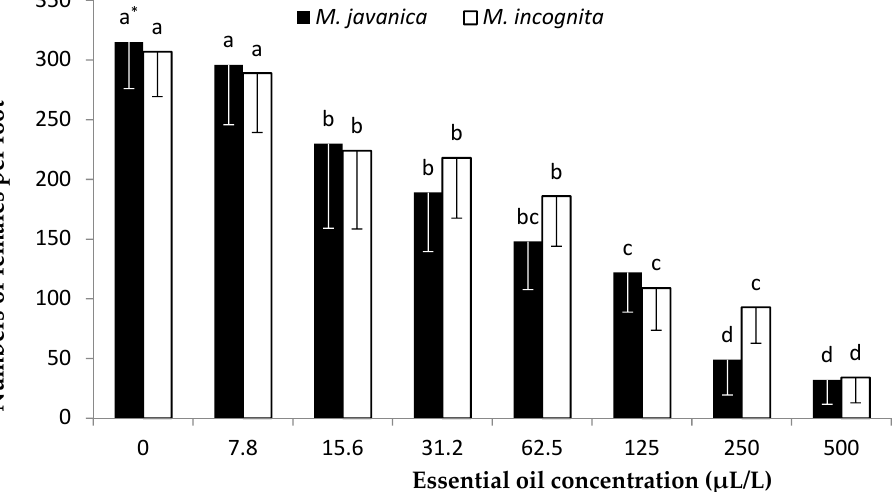
Figure 7. Number of females of Meloidogyne javanica and M. incognita per tomato root system in soil treated with Cuminum cyminum seed essential oil (EO) at concentrations of 0, 7.8, 15.6, 31.2, 62.5, 125, 250, and 500 μ L/L and inoculating with 600 J2s. * Bars with the same color followed by the same letter are not significantly different according to Tukey’s HSD test at p < 0.05.